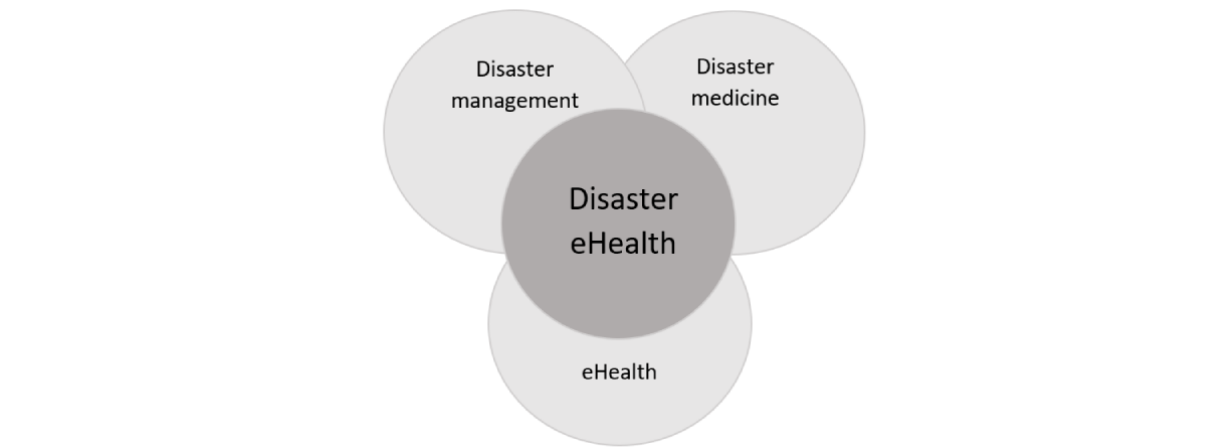
Figure 1. Disaster eHealth and its